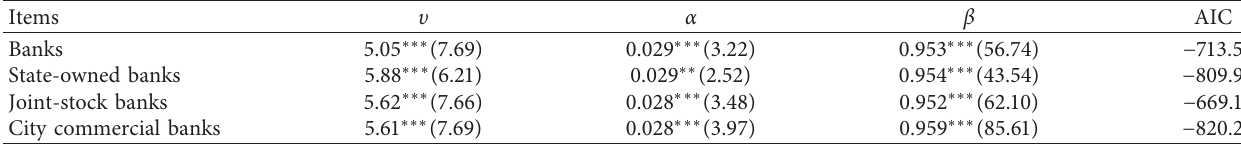
Table 3: Parameter estimation results of the time-varying t -copula model by SMEs on different banks.